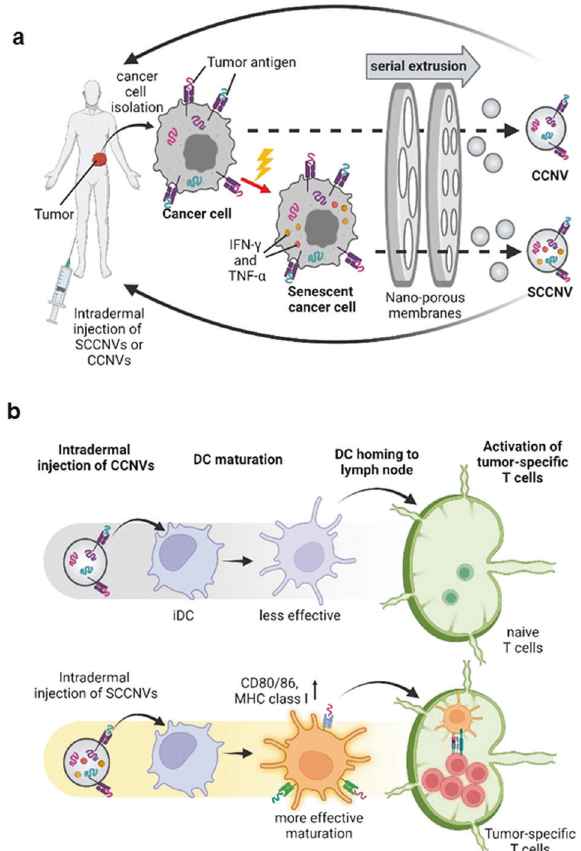
Fig. 1 Experimental scheme of SCCNVs. Illustration of ( a ) SCCNV preparation and personalized cancer vaccination and ( b ) the proposed mode of action of the vaccines. SCCNV senescent cancer cell-derived nanovesicle, CCNV cancer cell-derived nanovesicle, iDC immature dendritic cell, mDC mature dendritic